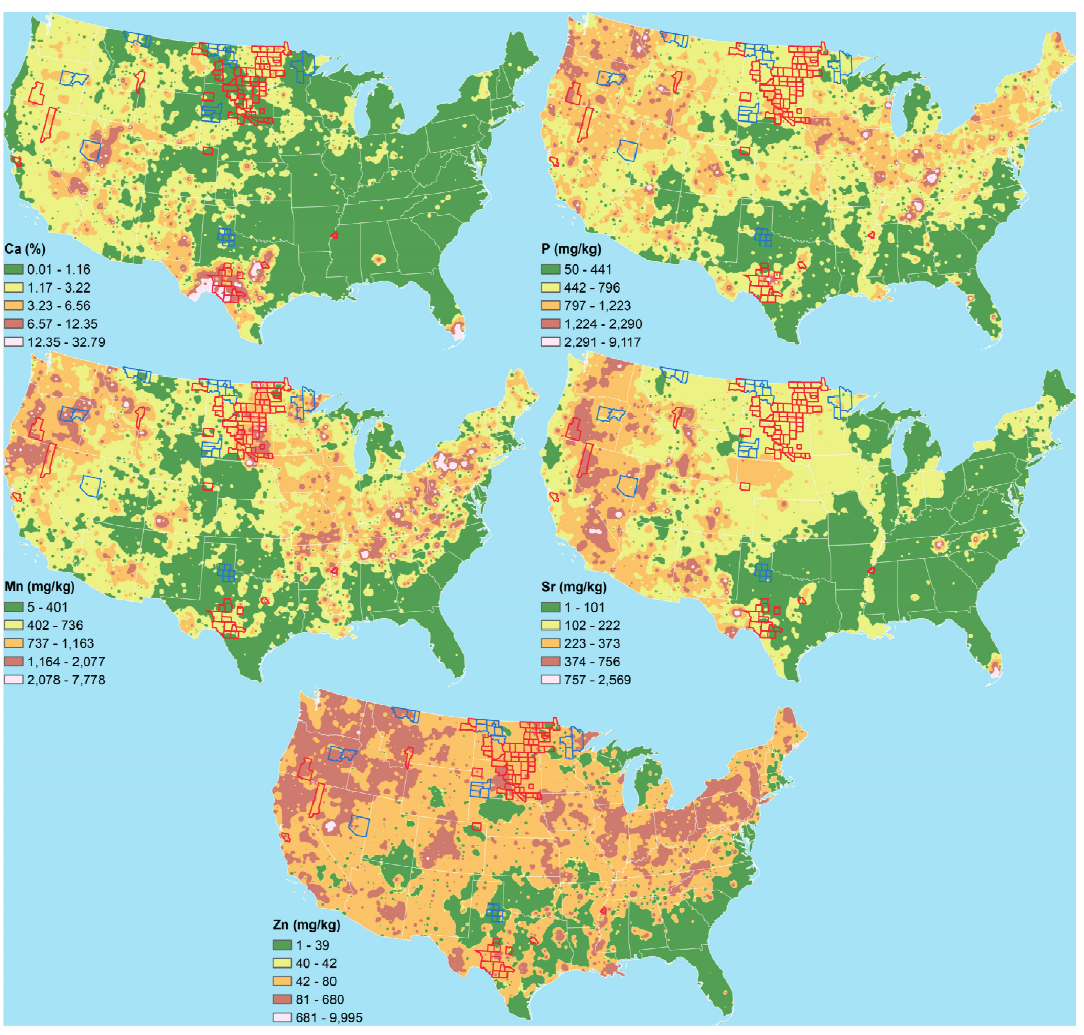
Figure 2. Calcium, phosphorus, manganese, strontium and zinc soil concentration gradient maps for the contiguous United States. Red counties = cases and/or outbreaks of agricultural/wildlife anthrax since 2000. Blue counties = no reported cases and utilized for geochemical statistical comparisons with red counties.